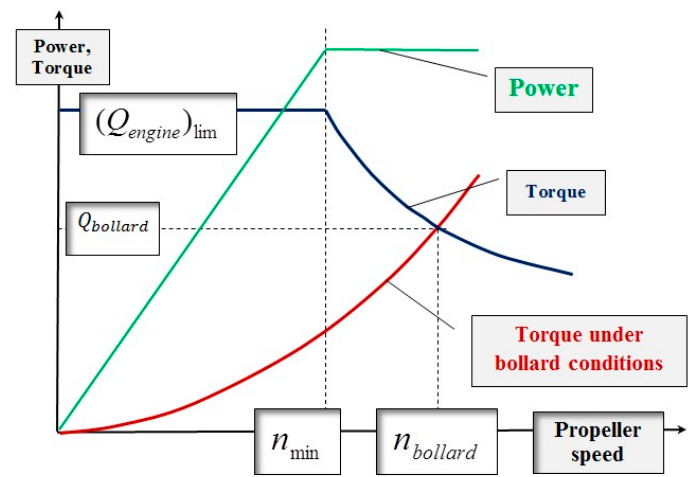
Figure 7. Scheme of engine power and torque for the main electric engine depending on propeller speed according to guideline of supplier of “Azipod” Azimuth Thruster [1].